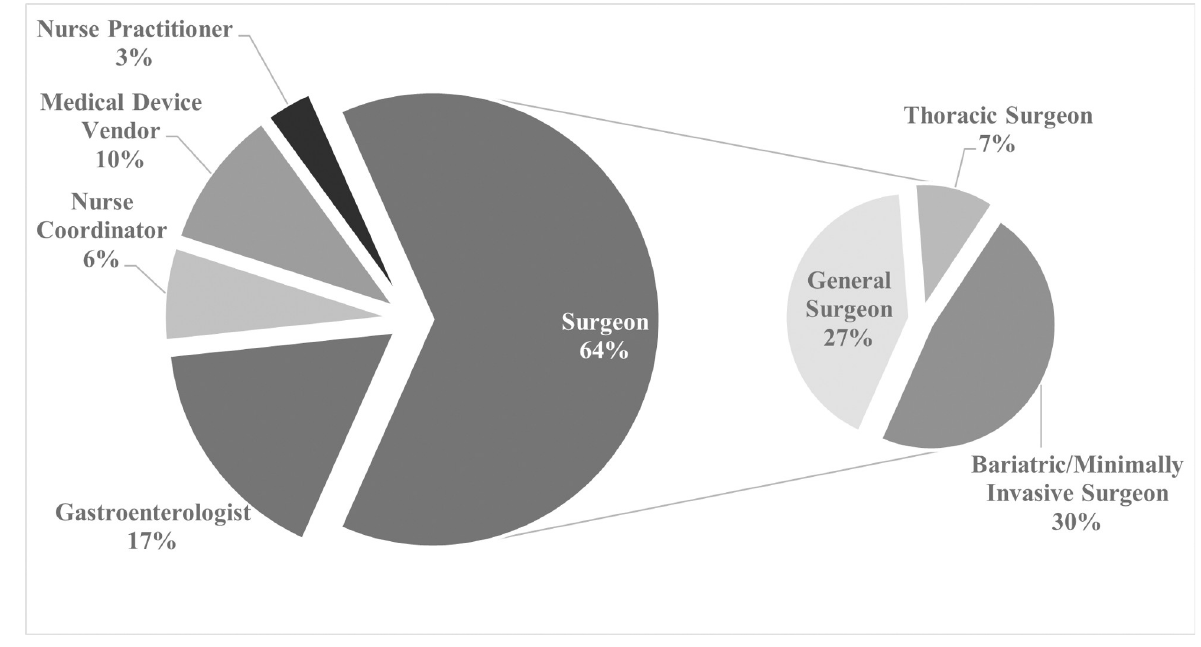
Fig 1. Distribution of interviewees by